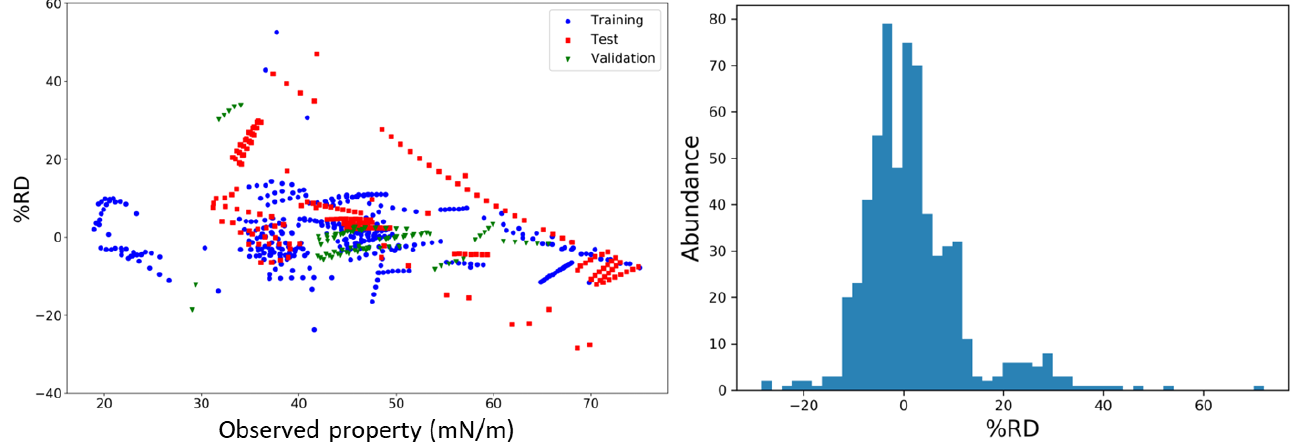
Figure 2. Relative deviations (%RD) between the predicted and observed DES surface tensions ( left ) and histogram plot of the distribution of %RD values ( right ).